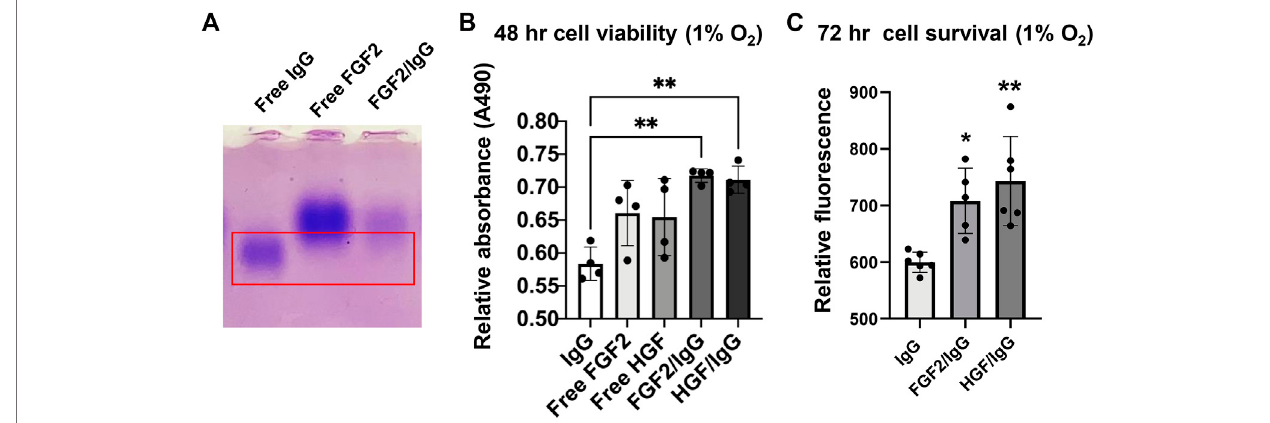
FIGURE 4 | FGF2/IgG complexes protect primary human cardiac microvascular endothelial cells against simulated ischemia for 48 – 72 h. (A) Native isoelectric focusing gel to detect protein complexes. Lanes: 1) free IgG (alone); 2) free FGF2 (alone); 3) FGF2/IgG complexes. Gel was stained for 30 min with Coomassie brilliant blue and de-stained overnight in 10% acetic acid. Red box: note that the protein band expected for free IgG is absent in the right-hand lane with FGF2/IgG complexes. (B) MTSassaydemonstratedincreasedcellviabilityconferredbyFGF2/IgGandHGF/IgGcomplexesrelativetoIgGalone(matcheddose)after48 hofexposureto 1% oxygen and nutrientdeprivation. Dataaremean ± SD, n= 4experimental replicates.* p < 0.05, compared withIgG. (C) CyQuant assaysshowed thatFGF2/IgG and HGF/IgG complexes protected human cardiac microvascular endothelial cells against simulated ischemia for 72 h. Data are mean ± SD and were analyzed by one-way ANOVA with post-hoc comparisons. n = 6 experimental replicates. ** p < 0.01, compared with IgG.